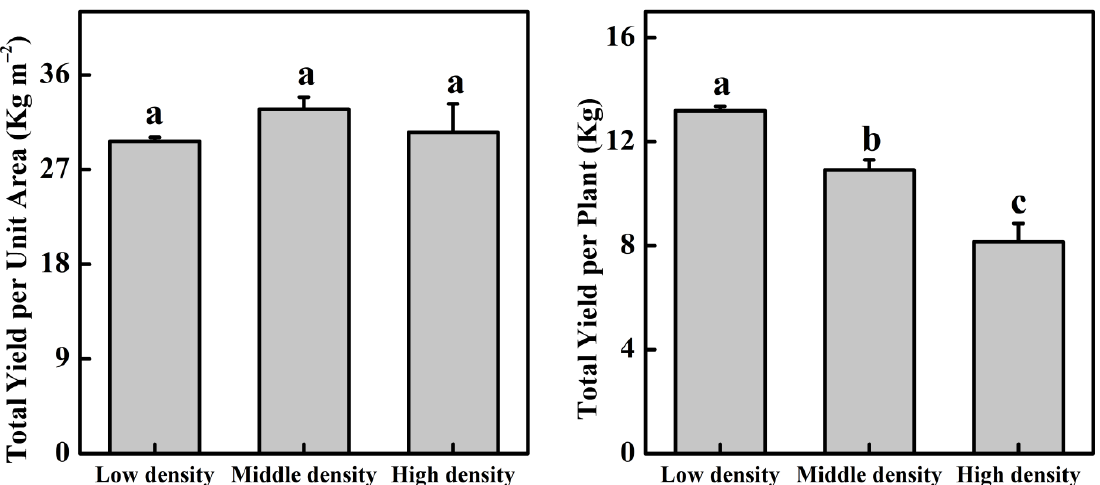
Figure 4. Cucumber total yield per unit area and total yield per plant of different density treat- ments in three harvest periods. The data represent the mean ± SD (n = 4). Different letters indicate